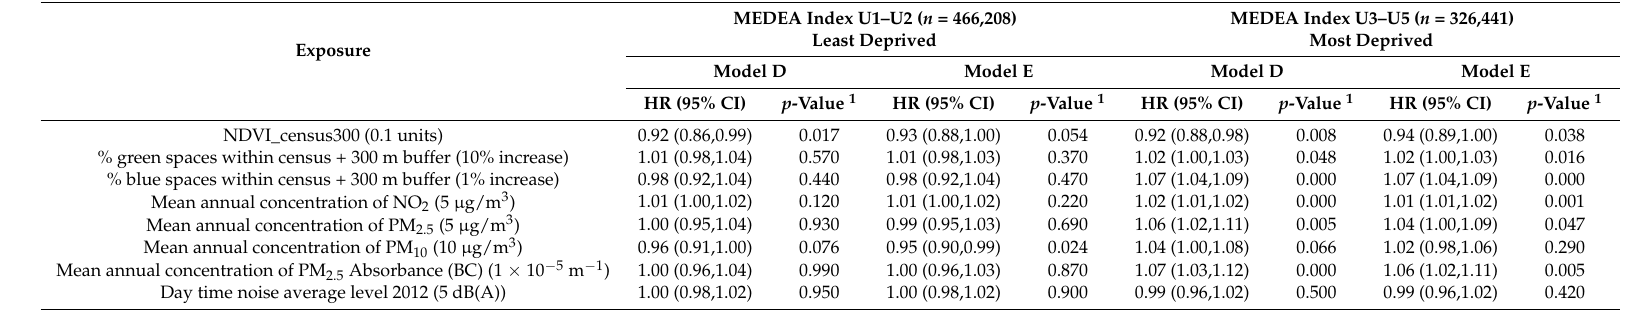
Table 5. Models of single pollutants (PM 2.5 , NVDI, GS, BS, Noise) by SES.